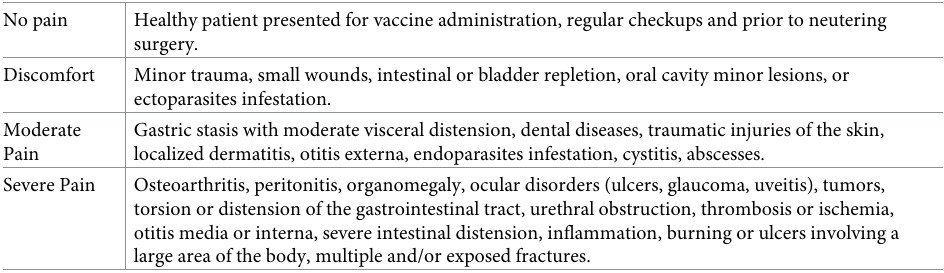
Table 1. Presumptive pain classes associated with some clinical conditions affecting rabbit patients